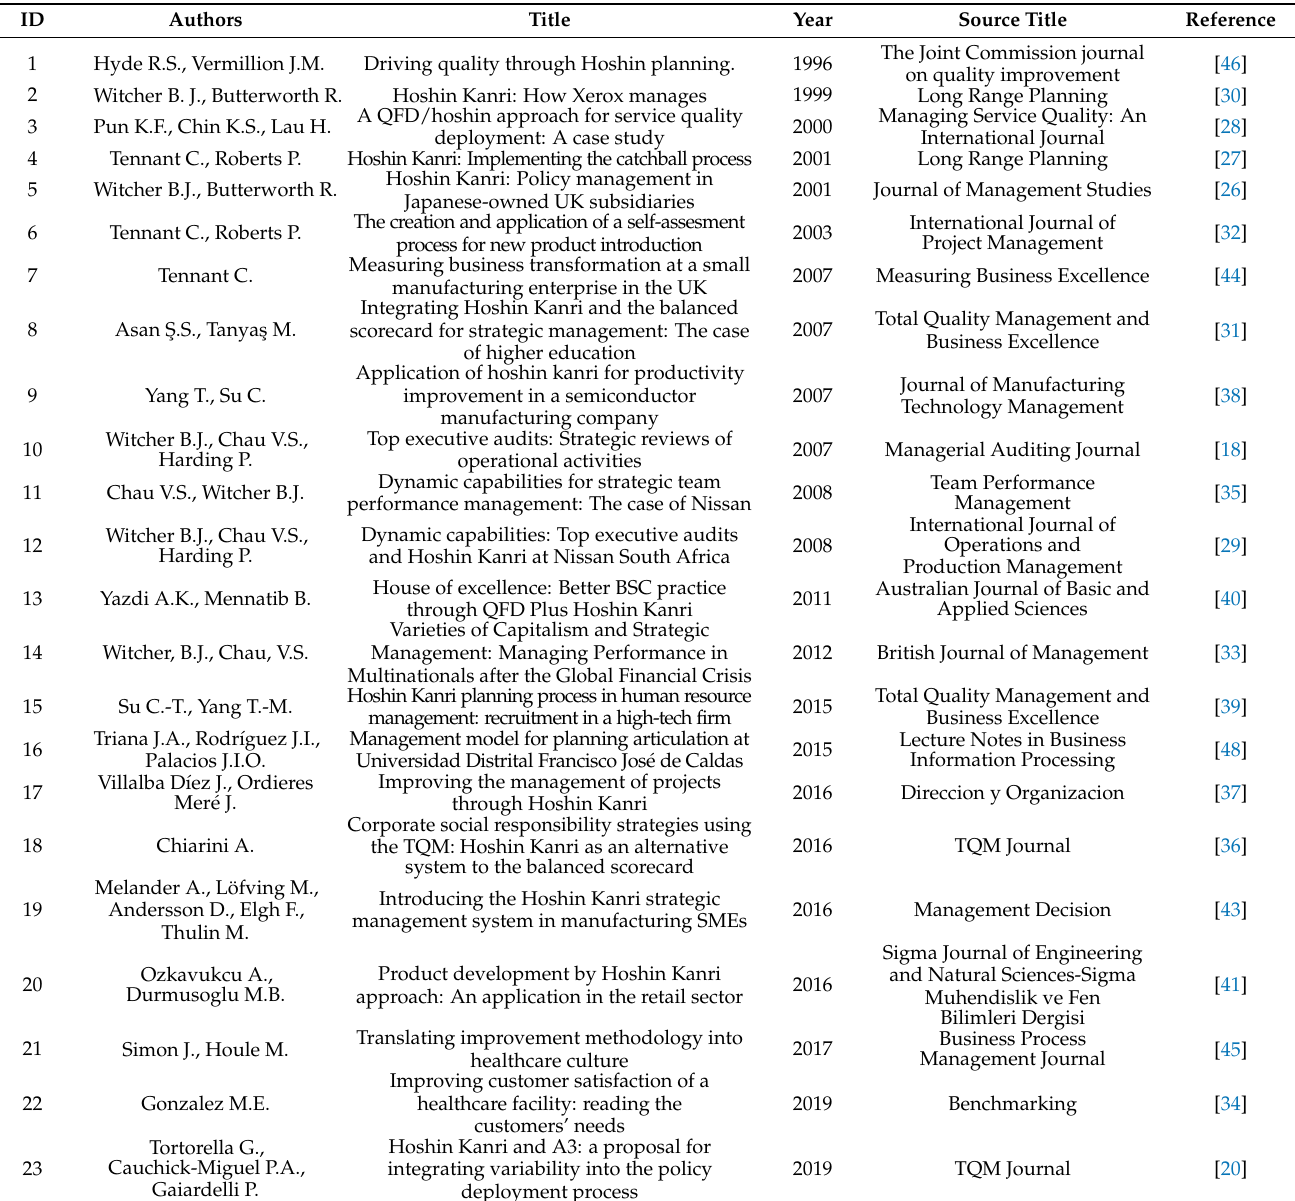
Table A1. Selected